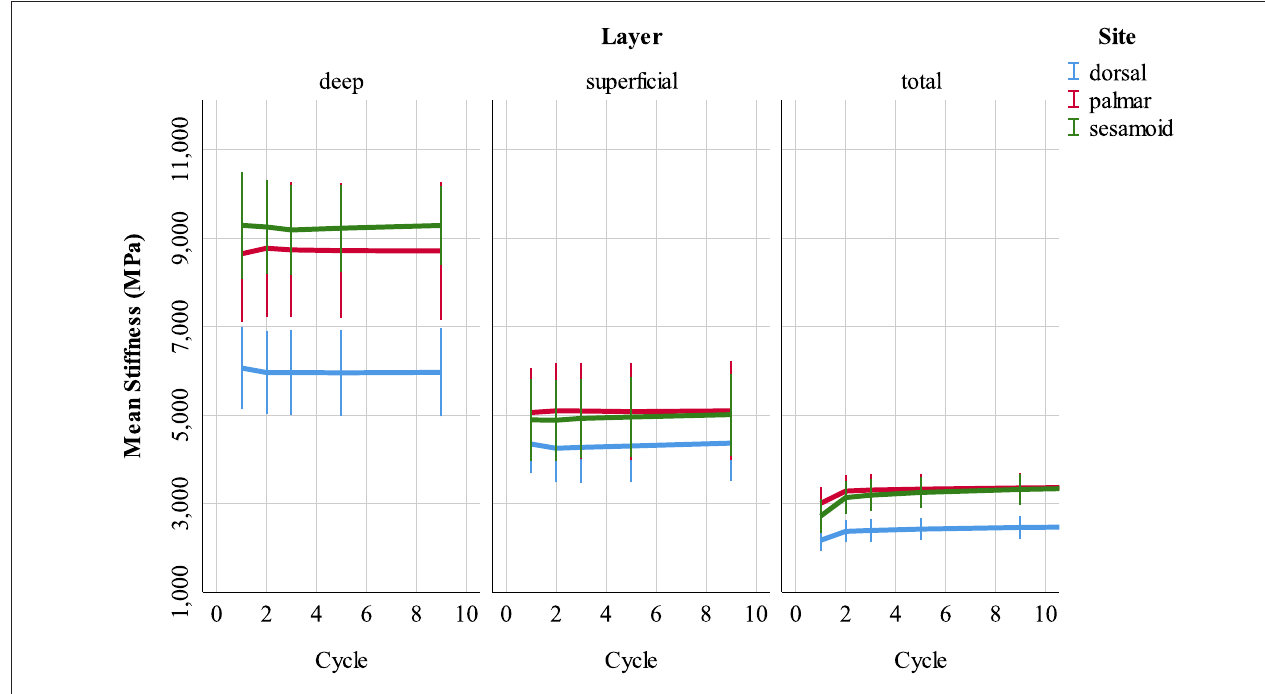
FIGURE 5 | Stiffness (MPa) of cartilage-bone specimens over the first nine compressive loading cycles at three sites (dorsal MCIII, palmar MCIII and proximal sesamoid) within the metacarpophalangeal joint of n = 10 Thoroughbred racehorses. Layers of each specimen (superficial 2mm, deeper 2mm, and total ∼ 10mm thick cartilage-bone) are stratified into columns. Unadjusted means with 95% confidence intervals are